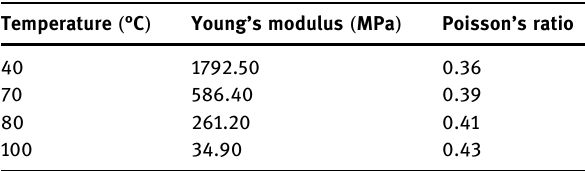
Table 4: Mechanical parameters of SMEP at di ff erent temperatures